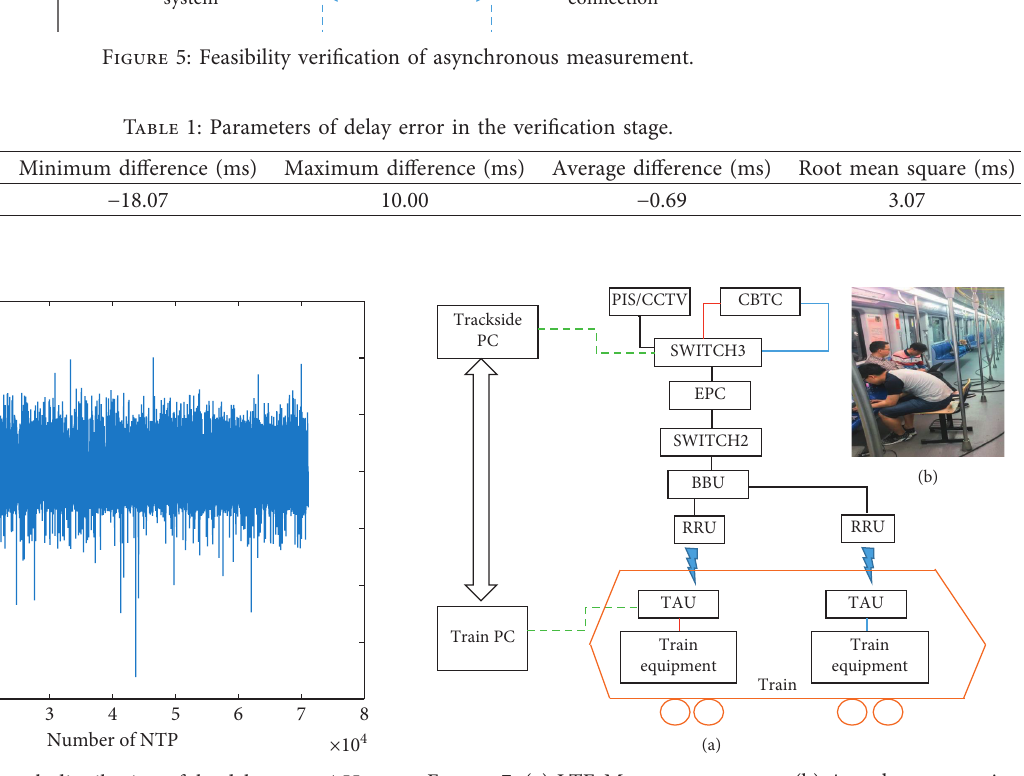
Figure 6: Measurement result distribution of the delay error Δ H